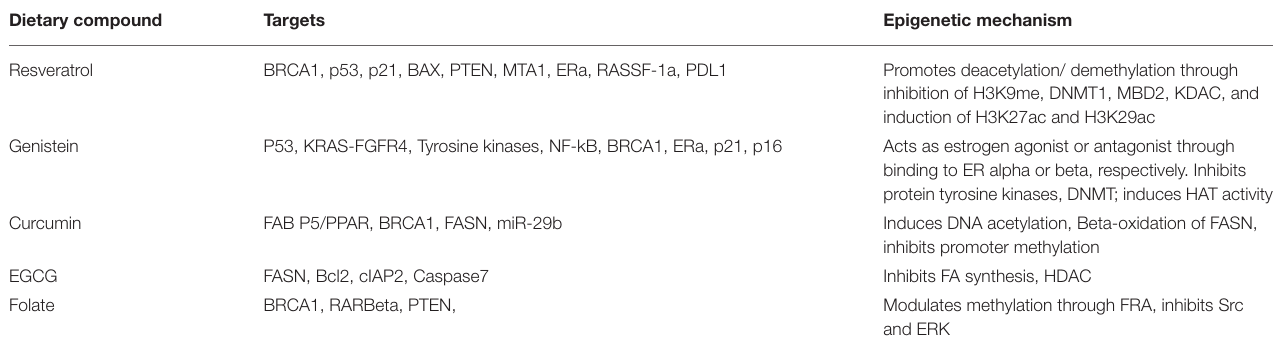
TABLE 2 | Dietary compounds, their proposed target genes and mechanisms of action in in vitro or in vivo models of TNBC. Dietary